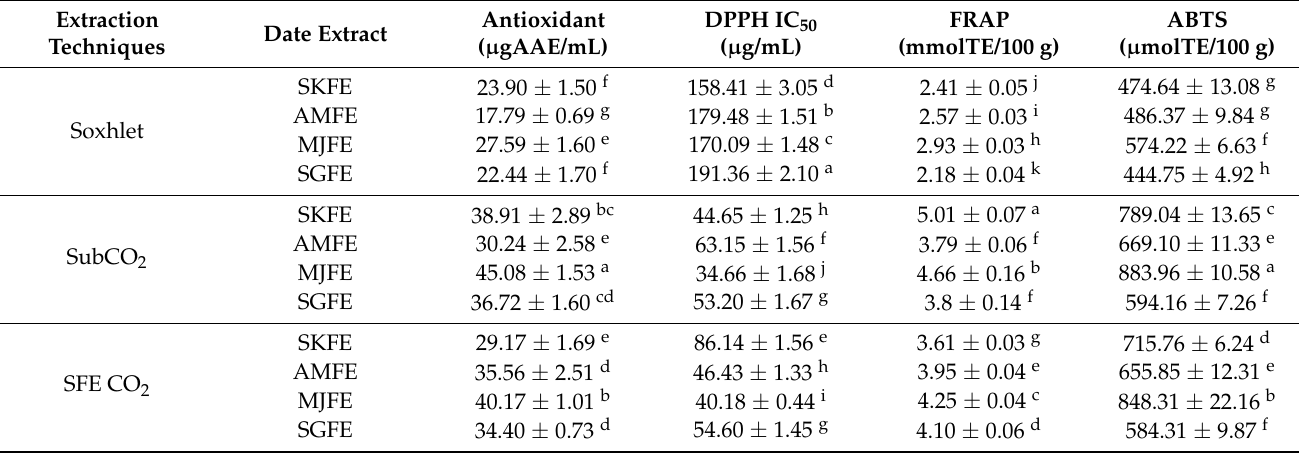
Table 4. Biological properties and antioxidant potential of date flesh extracts obtained using different extraction